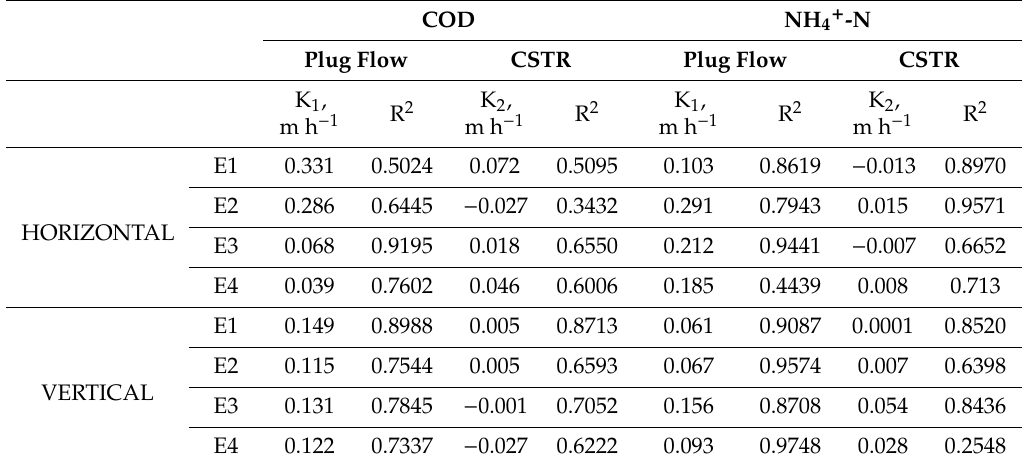
Table 3. Areal rate constants for the four stages of treatment of both pilot